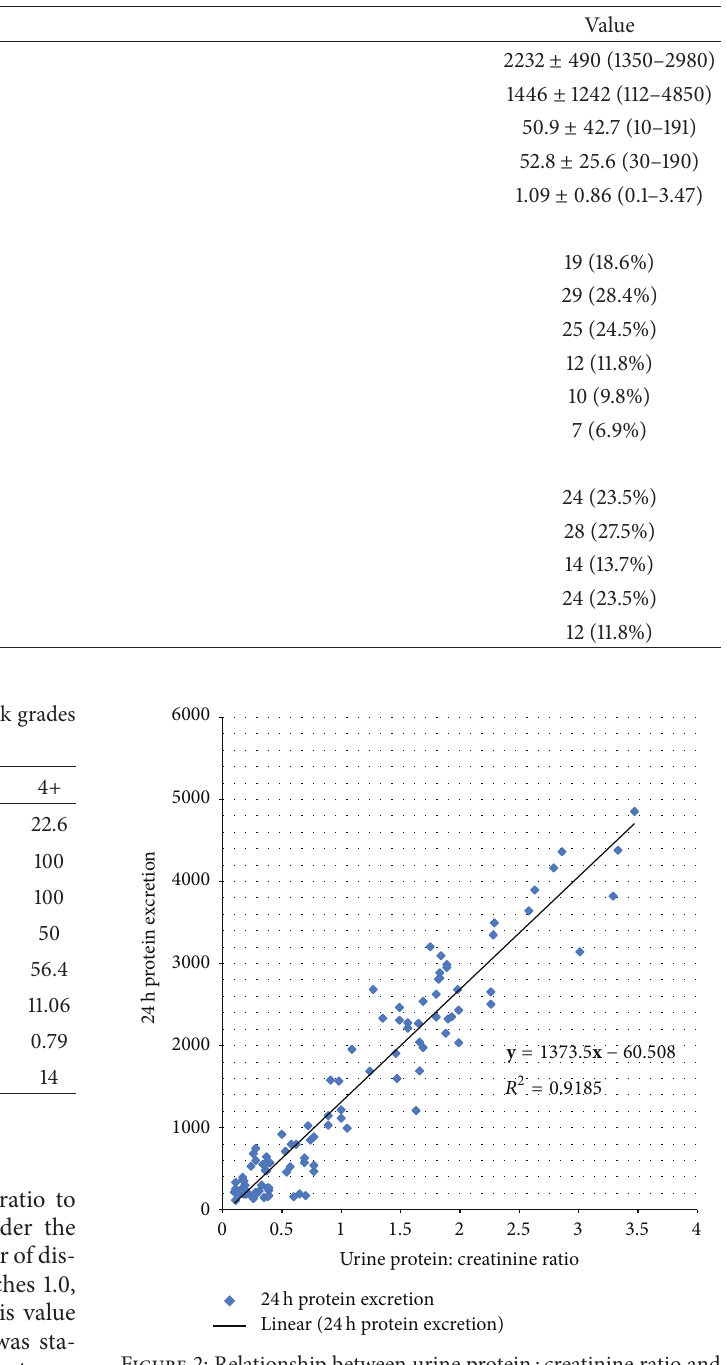
Figure 2: Relationship between urine protein :creatinine ratio and 24 hours